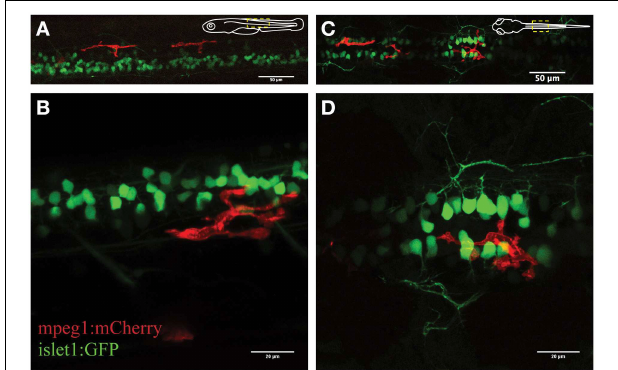
FIGURE 1 | Visualization of microglial activity in the spinal cord of 3 day old transgenic zebrafish expressing GFP-positive neurons ( islet1:GFP ) and mCherry-positive microglia ( mpeg1:mCherry ). (A) Overview (lateral) of the spinal cord and (B) enlarged lateral view of spinal neurons and a single microglia. (C) Dorsal view of the spinal cord microglia and (D) enlarged dorsal view. Schematic inserts in (A,C) depict orientation of the fish and outline the presented